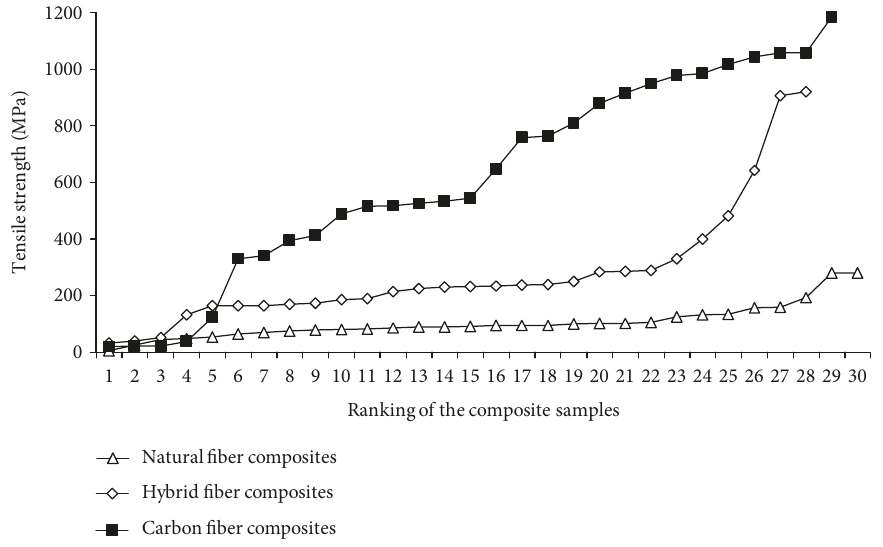
Figure 2: Tensile strength of carbon-/ fl ax-epoxy composites and nonhybrid carbon- and fl ax-epoxy composites [9, 12, 13, 17, 19, 21, 23, 25, 26, 40 –